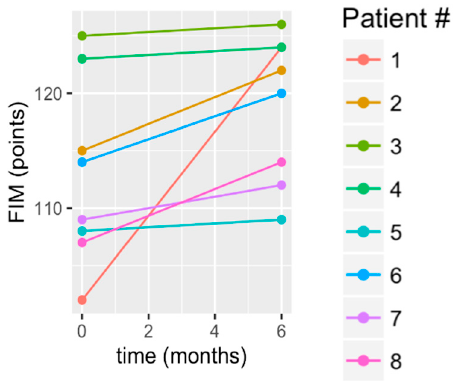
Figure 7. Change in the Functional Independence Measure (FIM) from baseline to 6 months.